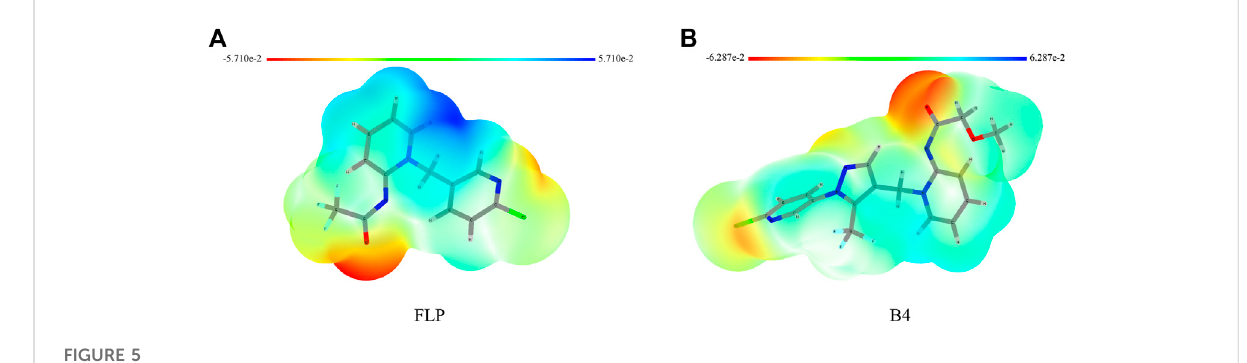
FIGURE 5 ESP of FLP (A) and B4 (B) .